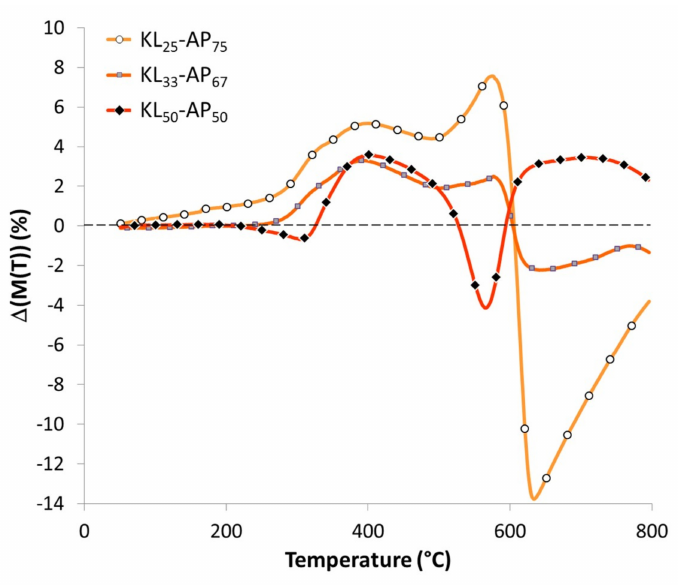
Figure 2. Curves of residual mass loss difference for KL-AP powder